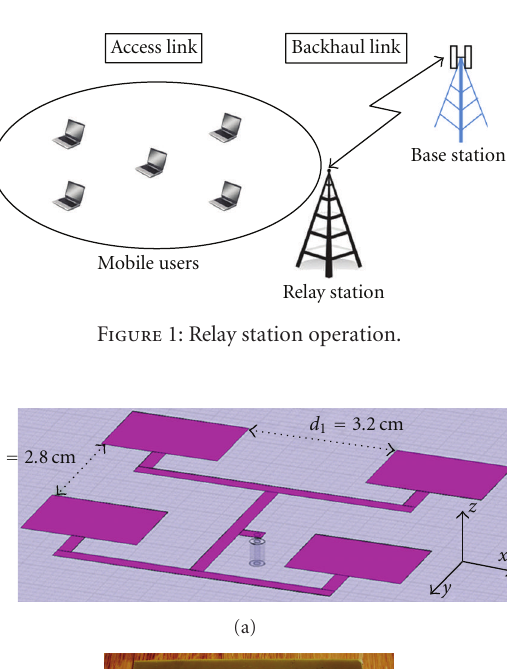
power that enters the antenna. That is why this antenna pre- sents narrow bandwidth